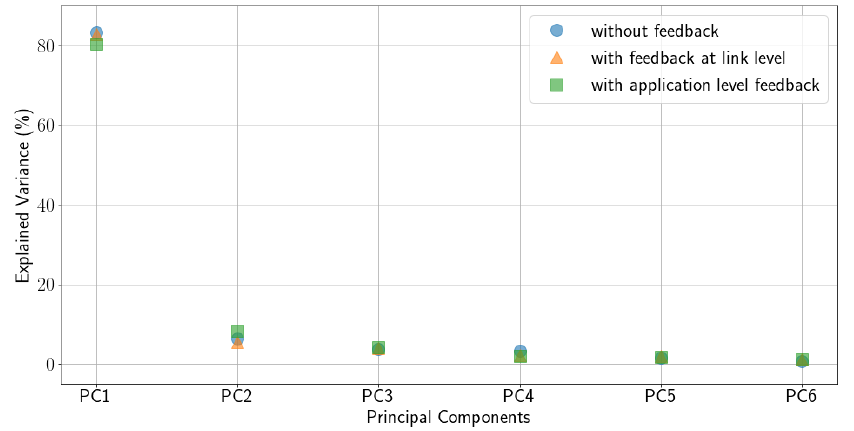
Figure 6. Explained variance of the different principal components in PCA.